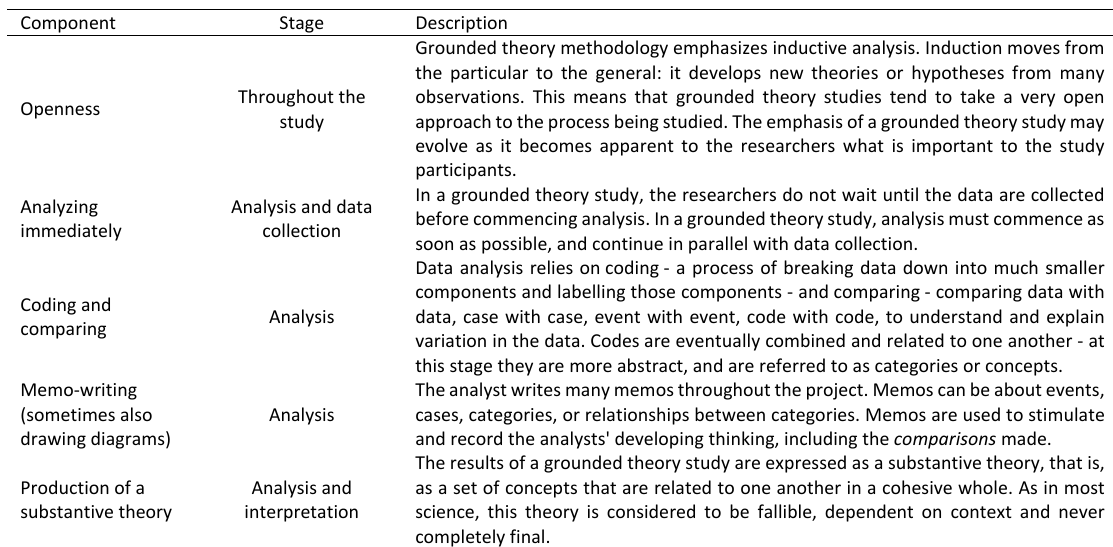
Table 1. Fundamental components of a Grounded Theory study